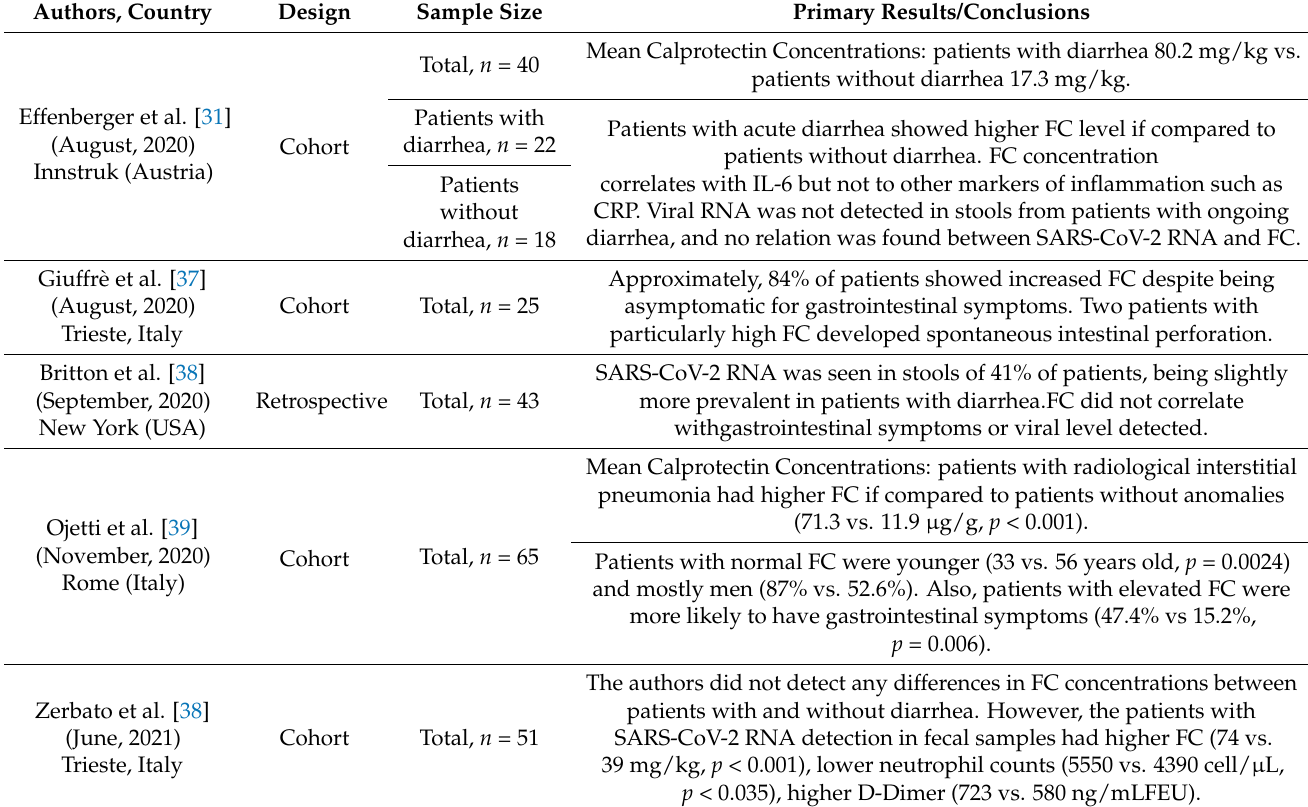
Table 2. Summary of current findings in terms of fecal calprotectin and COVID-19. CRP: C-reactive proteins; IL-6: interleukin-6; FC: fecal